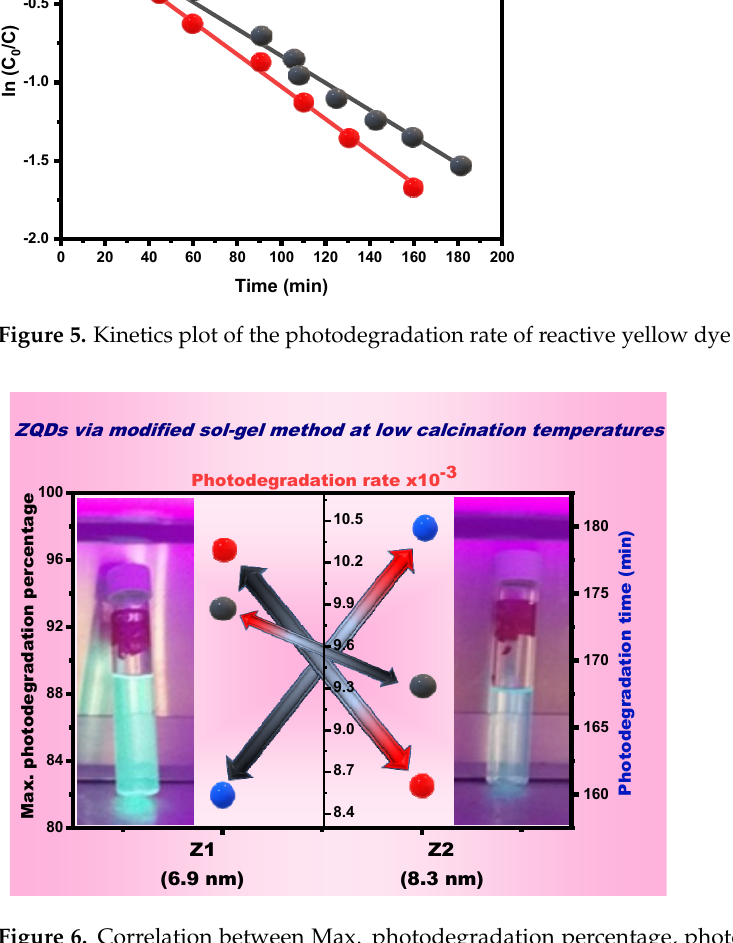
Figure 6. Correlation between Max. photodegradation percentage, photodegradation times, and photodegradation rate of